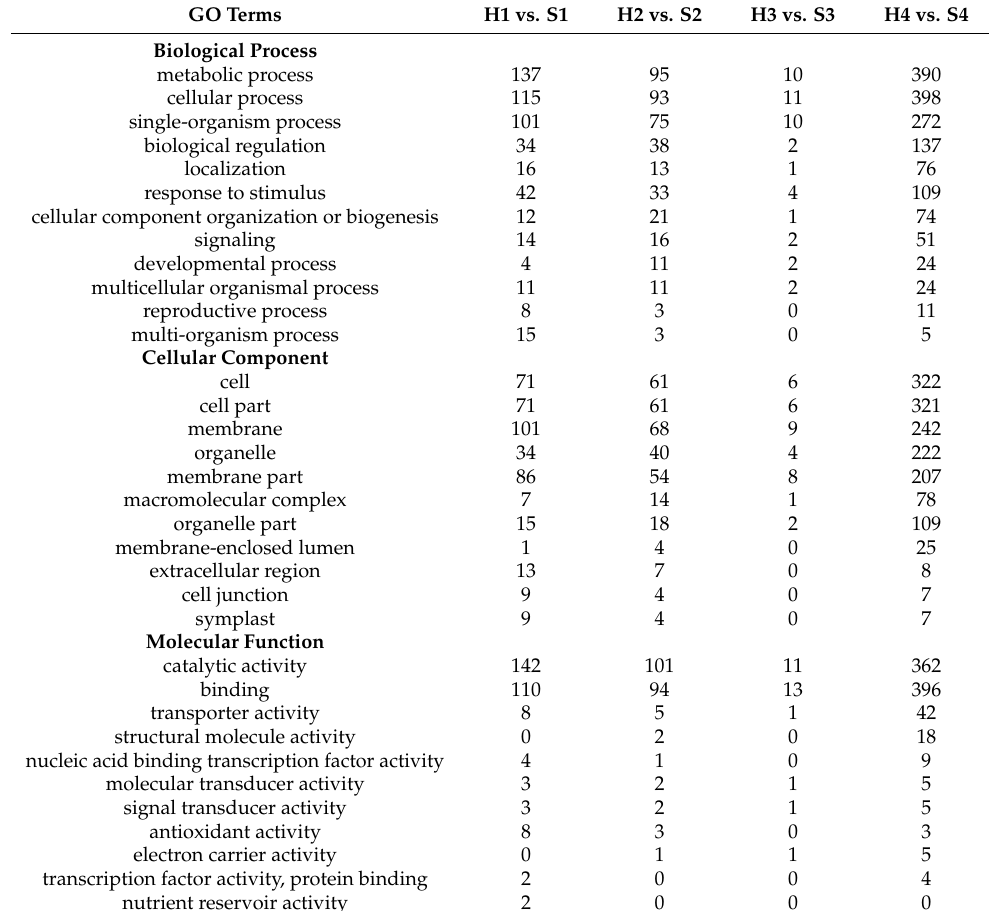
Table 3. GO analysis for differentially expressed genes of two alfalfa cultivars in four developmen- tal